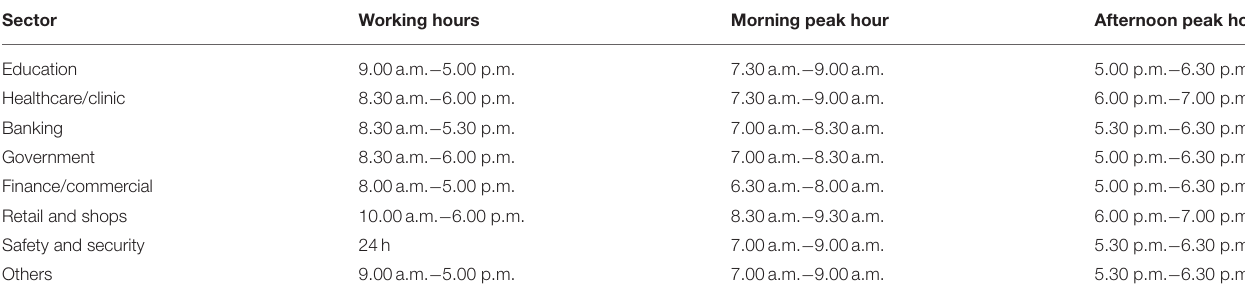
TABLE 1 | Sample of multiple sectors, operational hours, and peak hours (source: the Authors).